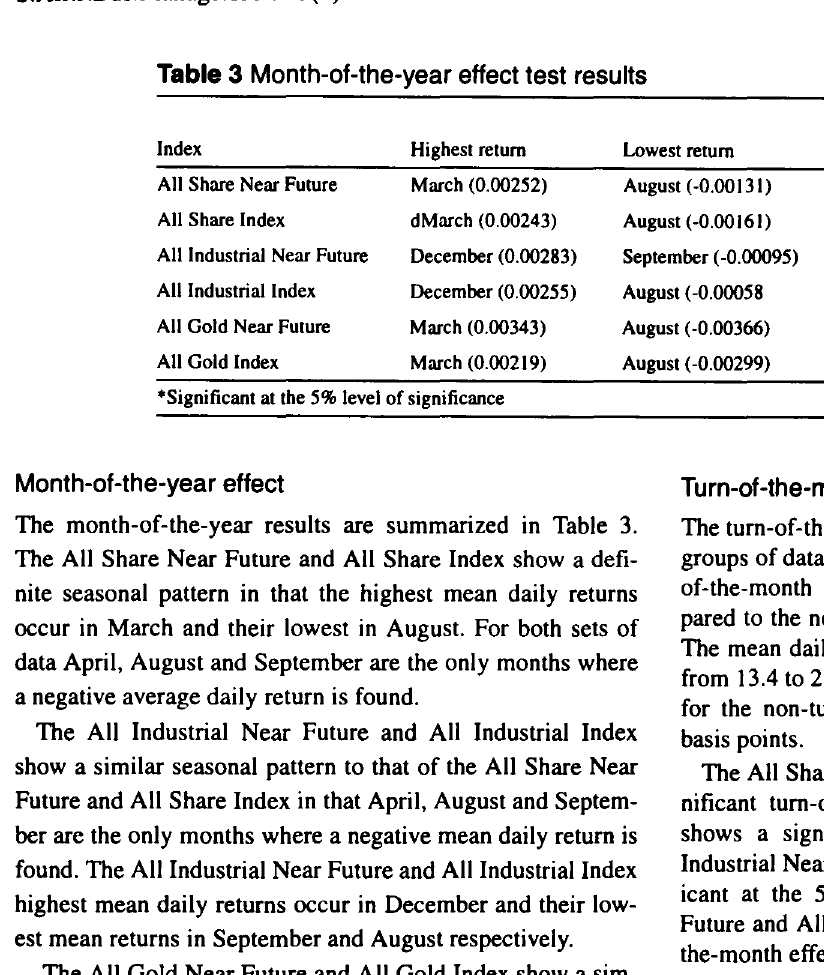
Table 3 Month-of-the-year effect test results